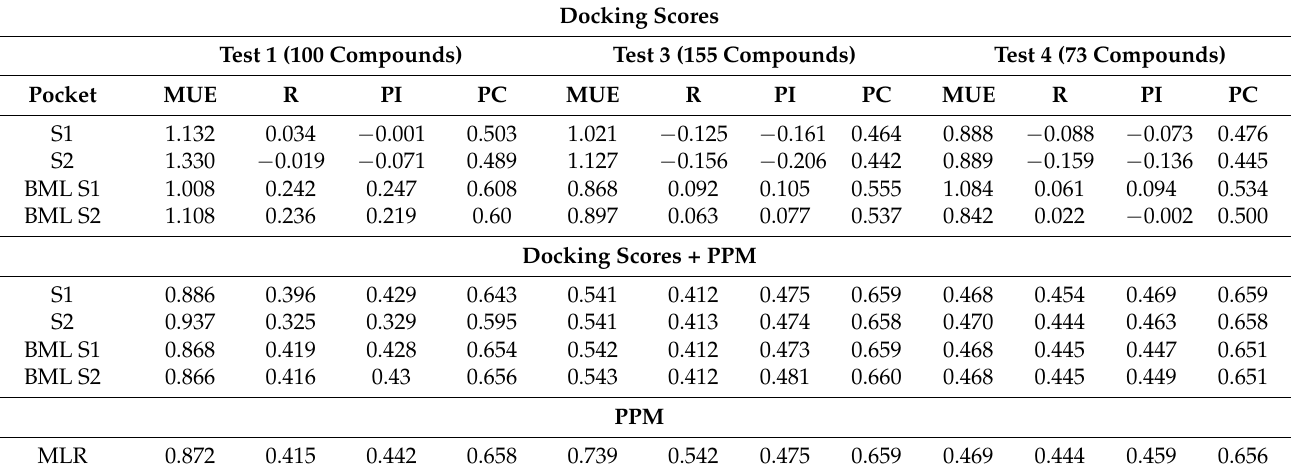
Table 4. Statistical analysis for Test sets 1, 3, and 4 in S1 and S2 binding pockets using the